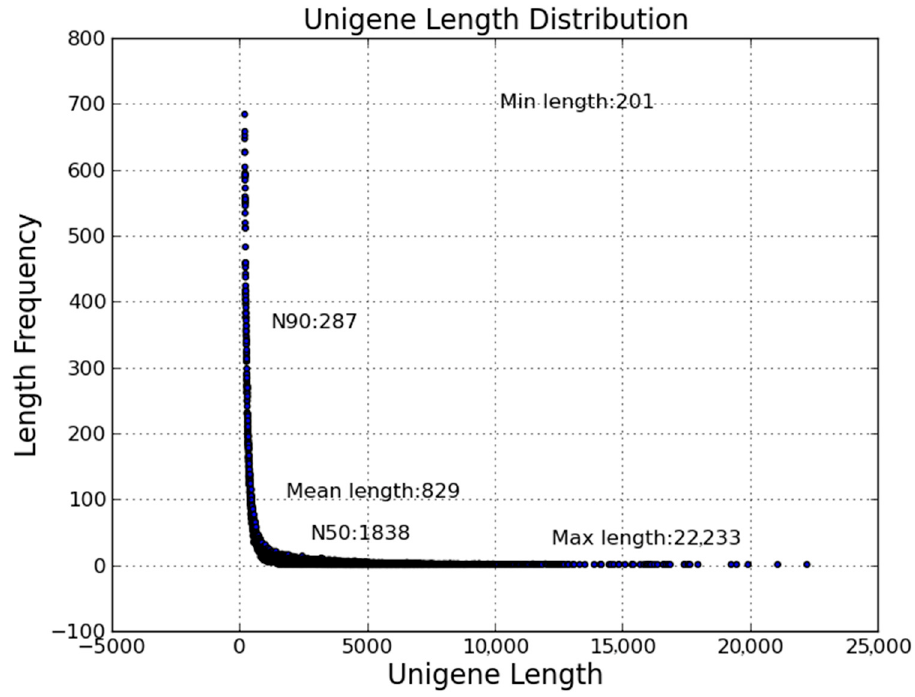
Figure 1. Length distribution of assembled unigenes. X -axis, unigene length; Y -axis, length frequency.